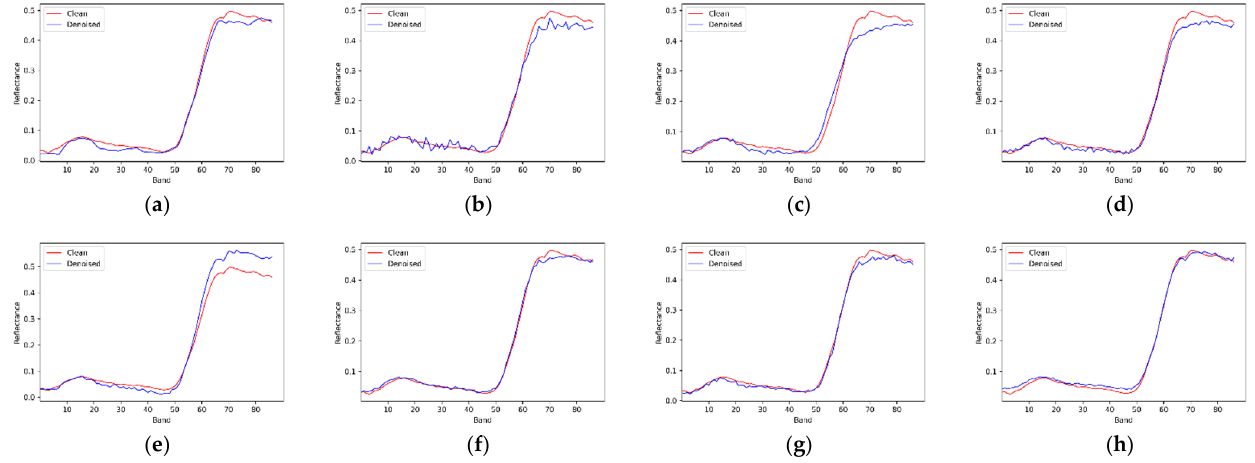
Figure 8. Recovery of spectral features by different denoising algorithms: ( a ) BM4D; ( b ) LRMR; ( c ) HyRes; ( d ) L1HyMixDe; ( e ) DHP-2D; ( f ) SIP; ( g ) SURE-CNN; and ( h ) 3S-HSID.